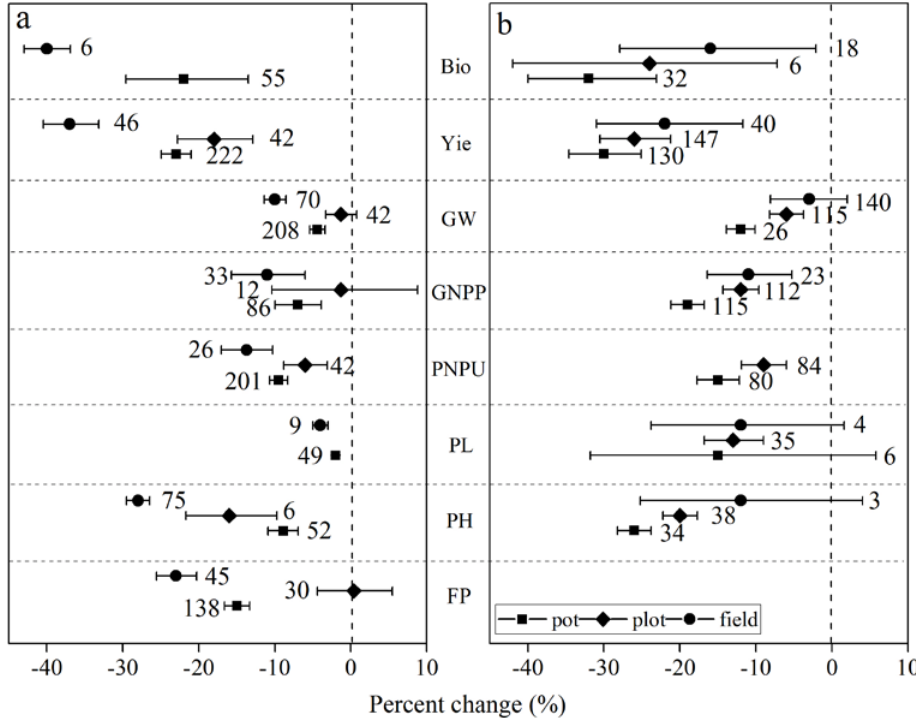
Figure 3. Response of rice and wheat to drought in different rooting environments. Numbers near the symbols specify the number of data points and the error bars indicate a 95% confidence interval (CI). Abbreviations for the agronomic traits are described in Table 2 ( a ) Rice, ( b ) Wheat.